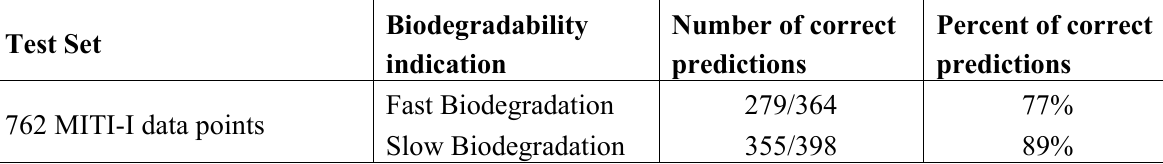
Table 7 . Results of Rule B when applied to MITI-I data test set